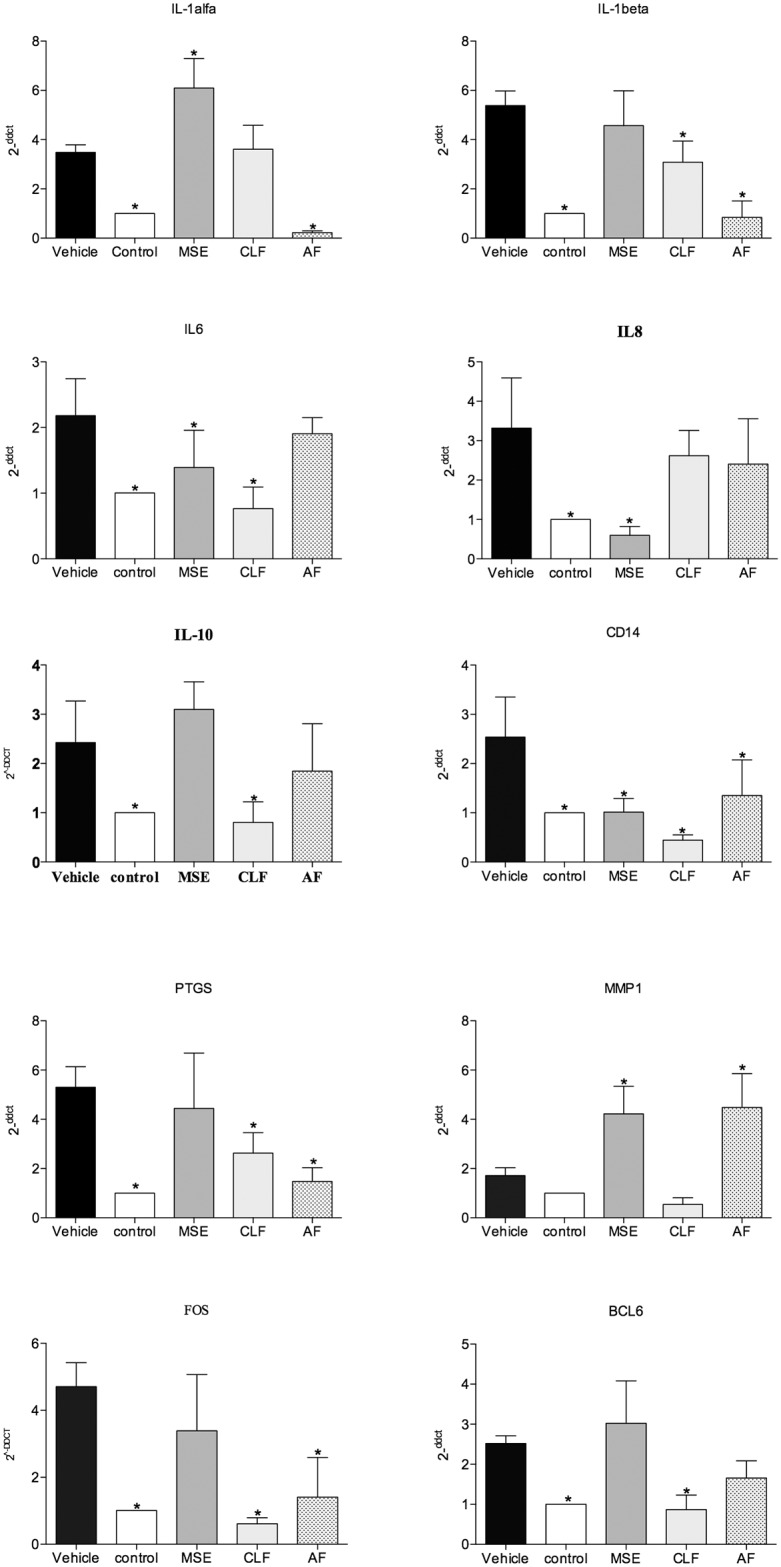
Gene expression analysis of lower chamber co-culture invasion assay.The expression levels of IL-1alfa, IL-1beta, IL-6, IL-8, IL-19, CD14, PTGS, MMP-1, FOS, BCL2 were evaluated and compared to the control (non-infected cells). Quantification of the relative transcript amounts was performed using qPCR with 50 ng of each cDNA. Data quantification was performed using the 2ΔΔCT method. Statistical analyses included one-way ANOVA followed by Dunnet’s post-hoc tests. A significance level of p < 0.05 (*) indicates differences from the vehicle group.